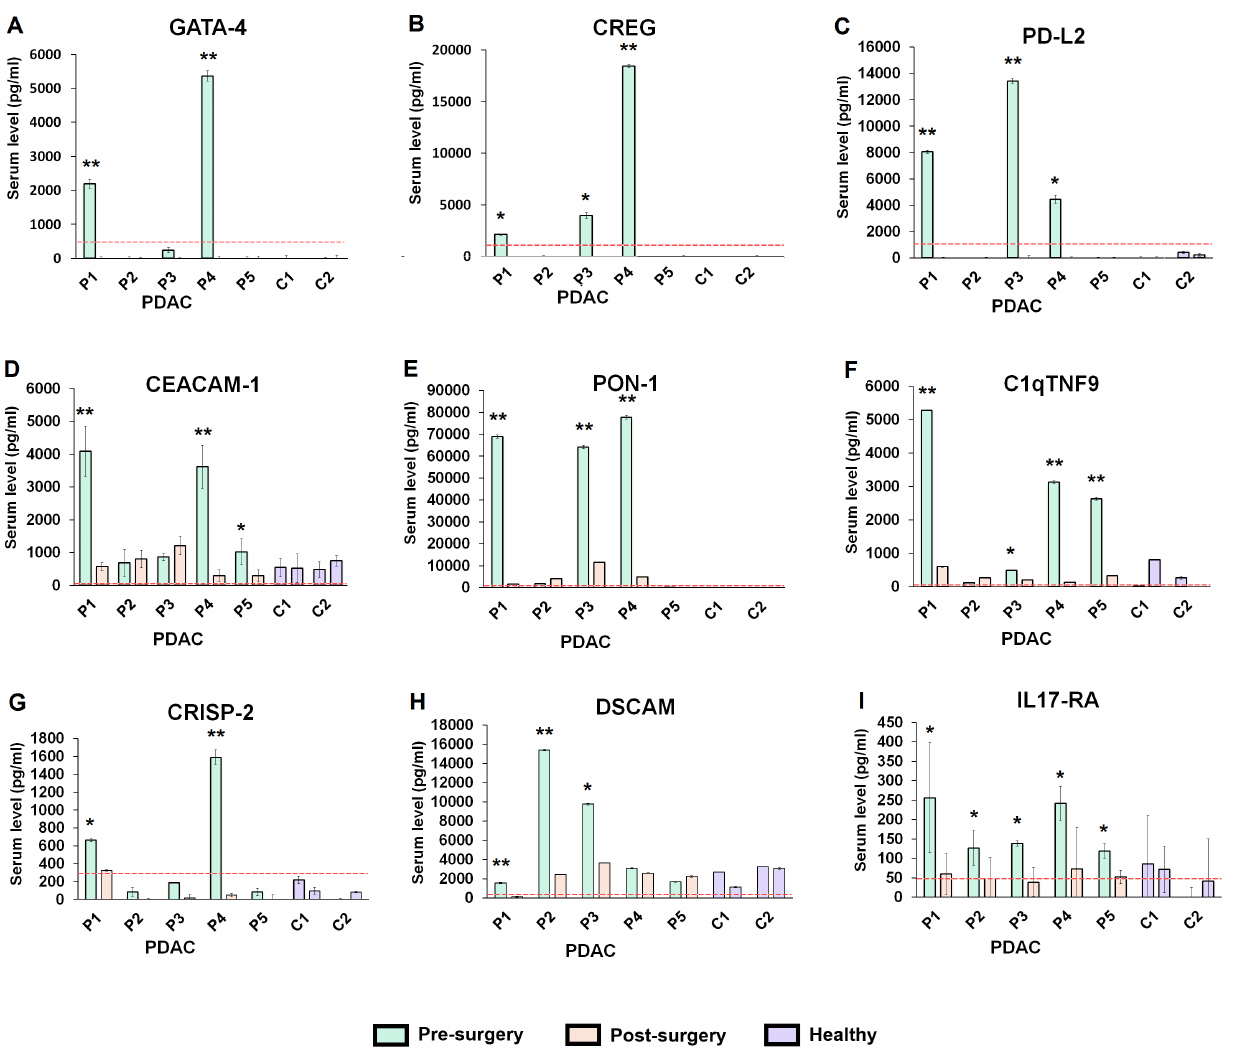
Figure 3. Multiplexed array results for the proteins that decreased in serum level following surgery in pancreatic cancer (PDAC) patients. Bar graphs depict normalized serum level of proteins in five PDAC patients (P1-P5), before and after surgery, and in two controls (C1 and C2). Red dashed line depicts limit of detection. Error bars represent 95% confidence intervals based on the technical quadruplicate values. * Post-surgical decrease of at least two-fold. ** Post-surgical decrease of at least five-fold. ( A – C ) Levels of CREG, GATA-4 and PD-L2 dropped to undetectable levels in patients who expressed the protein prior to surgery. ( D – F ) PON1, C1qTNF9 and CEACAM-1 levels decreased by at least five-fold in patients who highly expressed the protein pre-surgery. ( G – I ) DSCAM, IL-17RA and CRISP-2 levels decreased by at least two-fold in at least two of five